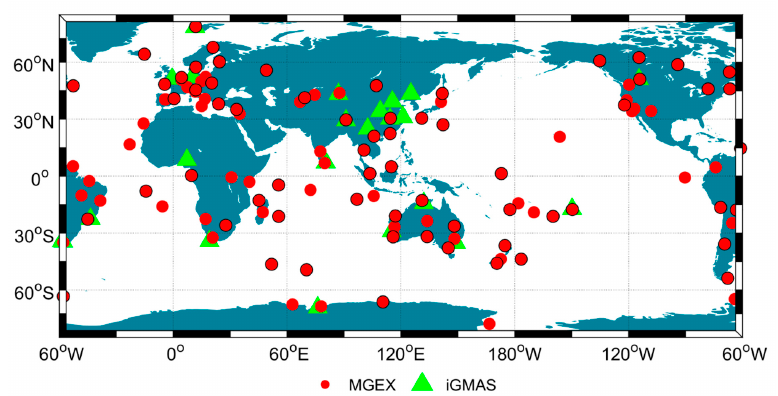
Figure 2. Distribution of global stations from MGEX and iGMAS. Table 3. Detailed processing strategy for the integrated multi-GNSS